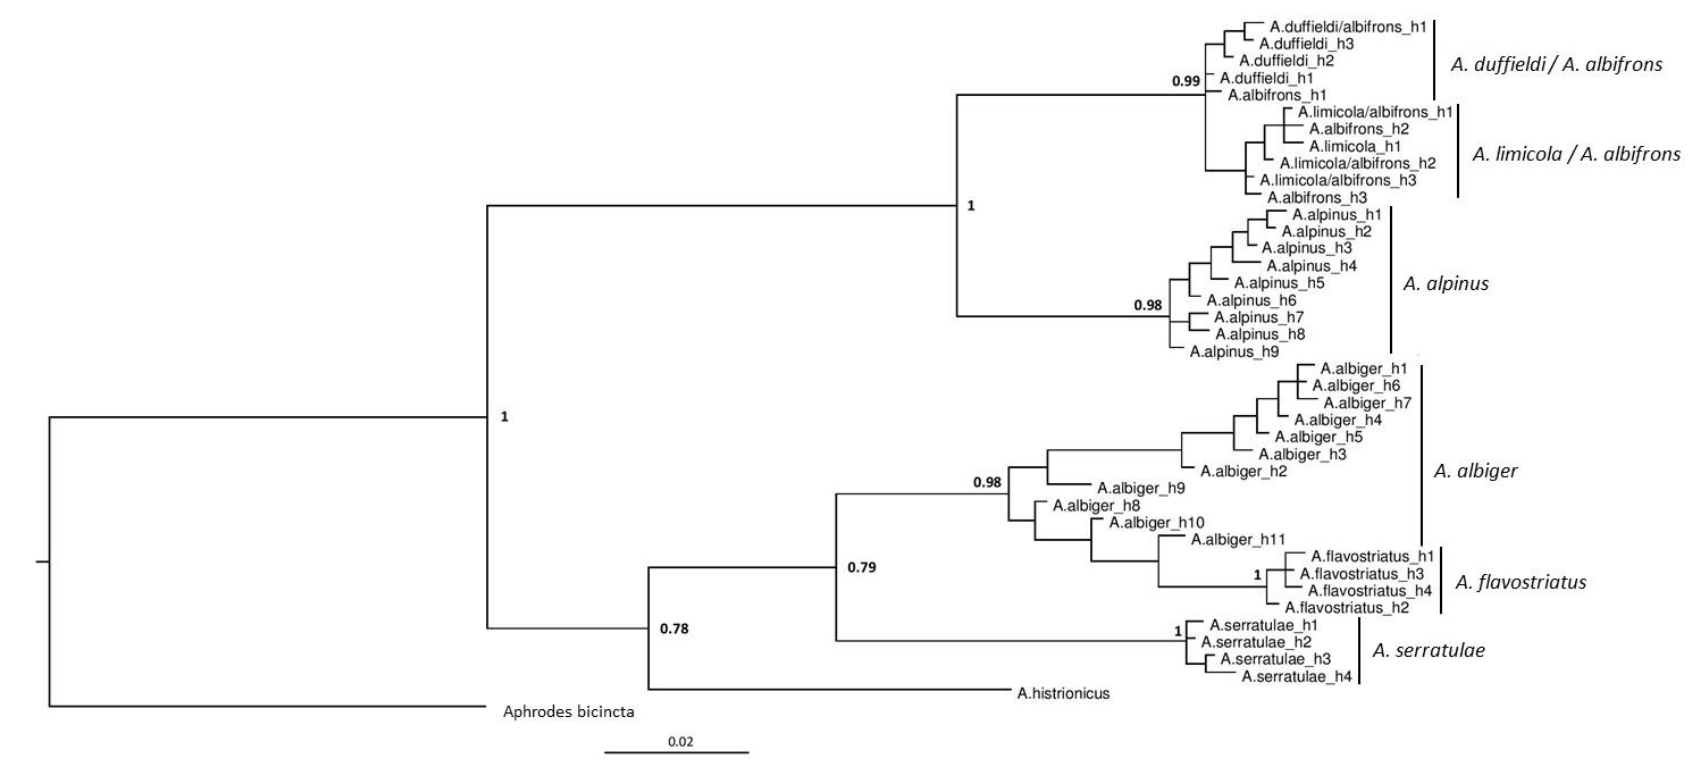
Figure 2. Bayesian phylogeny based on mitochondrial cytochrome c oxidase subunit I (CO1) DNA data. Haplotypes were identified in DnaSP v5.10.01 [55] from individual sequences, with species names separated by ‘/’ indicating shared haplotypes across two different taxa. Bayesian posterior probabilities are labelled at each node with the whole tree rooted by using the closely related Aphrodes bicincta as an outgroup .